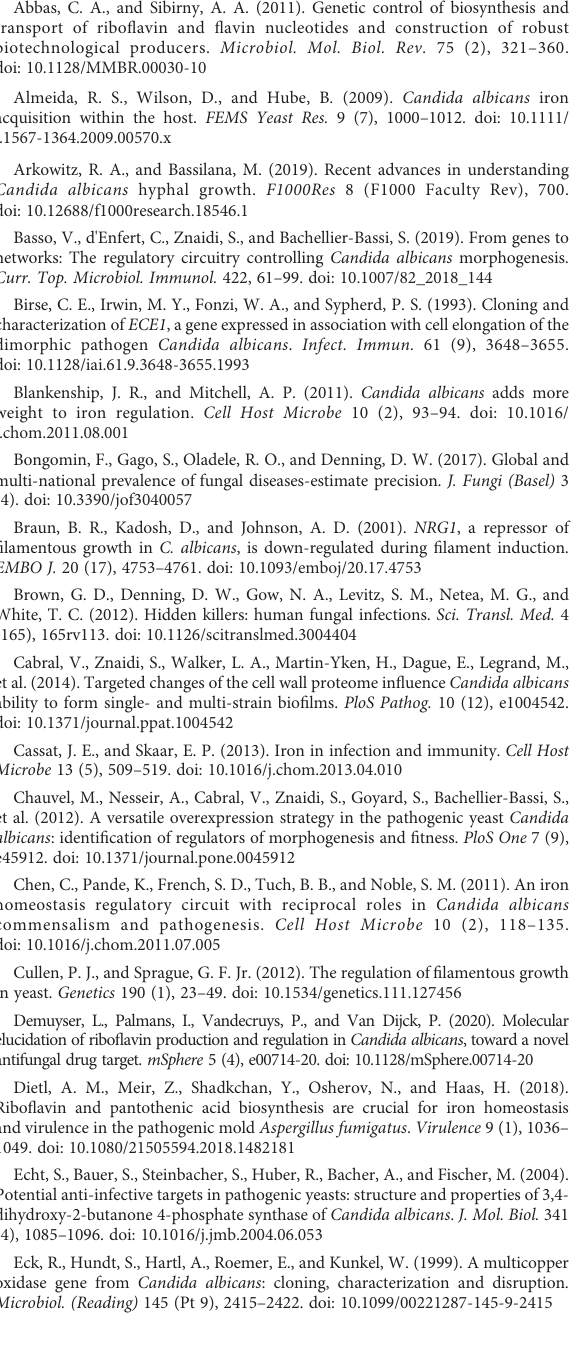
SUPPLEMENTARY FIGURE 5 Transcriptional control of Irf1 under iron starvation. Based on the relative transcript levels shown in , fold changes of the indicated genes were calculated, comparing treated with untreated growth conditions (+BPS/- BPS). Asterisks indicate signi fi cantdifferences in geneexpression between the two conditions determined by a two-tailed Student ’ s t -test. (*) P < 0.05; (**) P < 0.01; (***) P